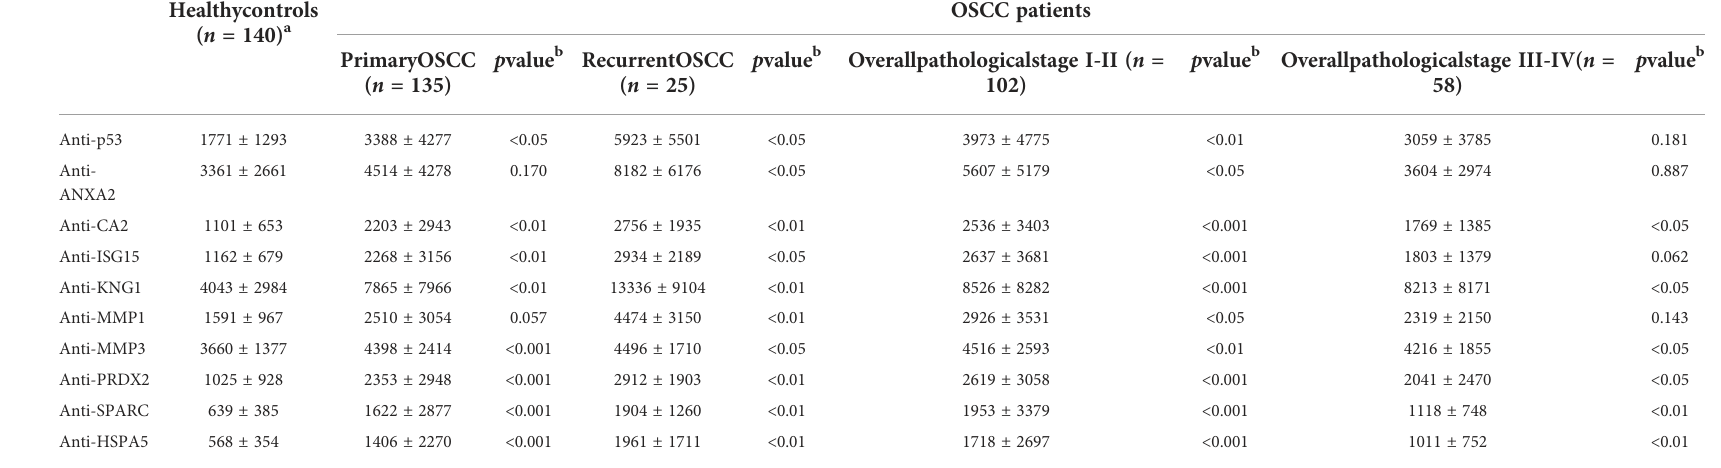
a MFI for the indicated group was shown as mean ± standard deviation (SD). b The p values for the comparison between the indicated group and the healthy control group were determined by a two-sample